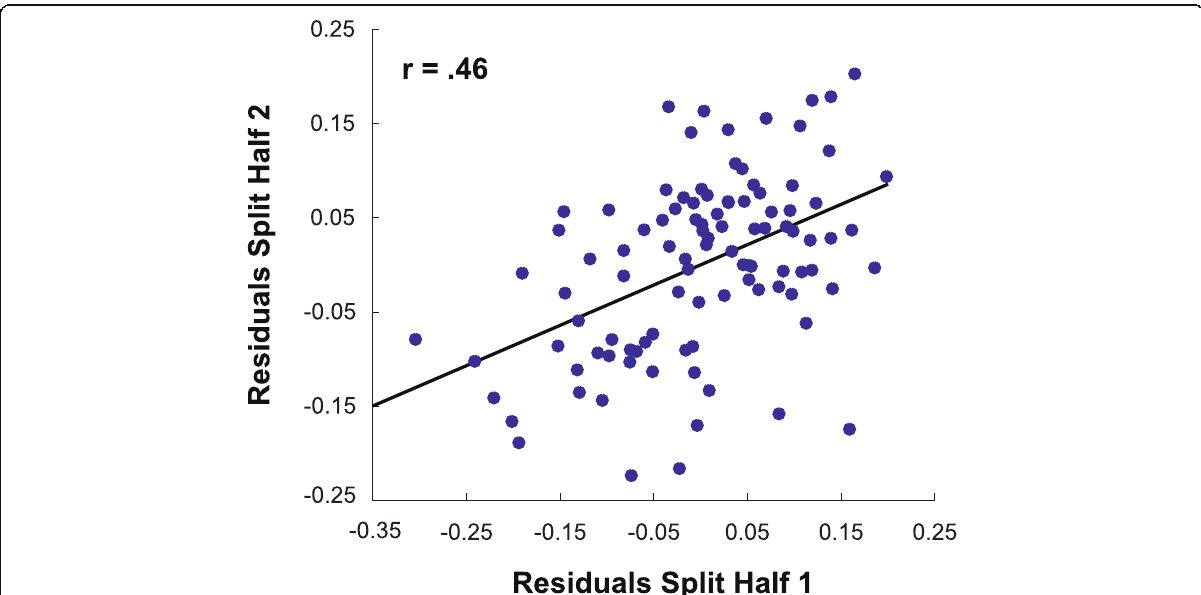
Fig. 4 Reliable variance in the Unstable Towers task after regressing out the contribution of spatial abilities and working memory. We ran a linear regression to find the degree to which a combination of the spatial and working memory measures could account for individual differences in performance on the towers task (see “ Methods ” ). We then found the residual (unexplained) variance in the towers task and plotted independent split halves of the data (each data point represents one participant). We identified robust positive correlation in this split-half analysis ( r (98) = 0.48, p < .001), indicating that reliable individual differences in physical prediction cannot be fully accounted for by spatial abilities or